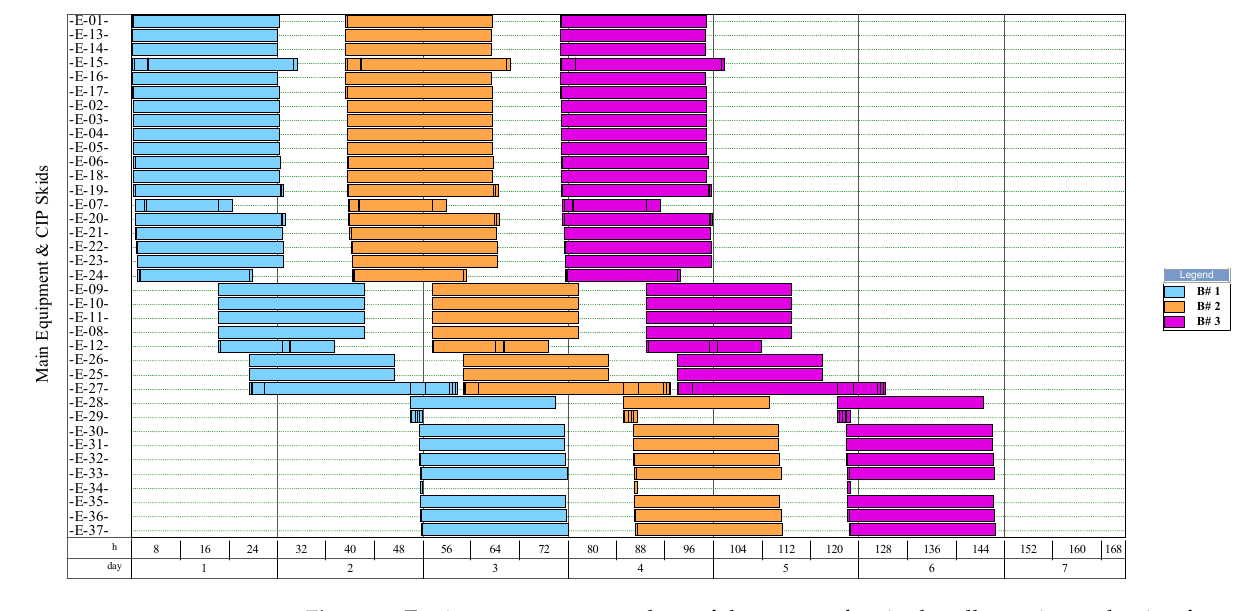
Figure 8. Equipment occupancy chart of the process for single-cell protein production from plantain pseudostems. B: batch; CIP: cleaning-in-place. The labels of the equipment units are shown in Figure 4.